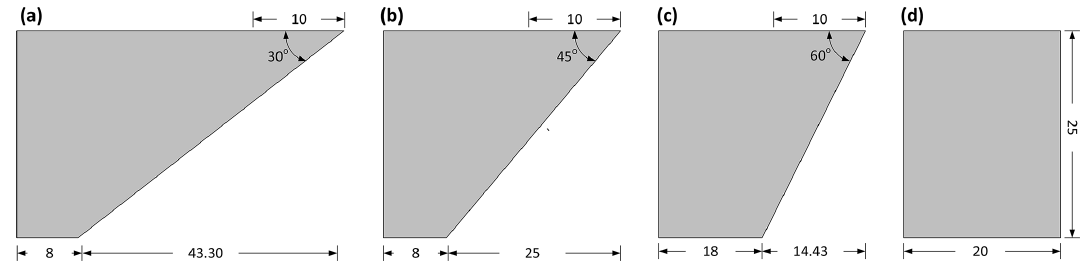
Figure 2. Dimensions (in mm) of tapered workpieces, (a) 30 ◦ tapered workpiece, (b) 45 ◦ tapered workpiece, (c) 60 ◦ tapered workpiece, (d) side view of tapered workpieces.